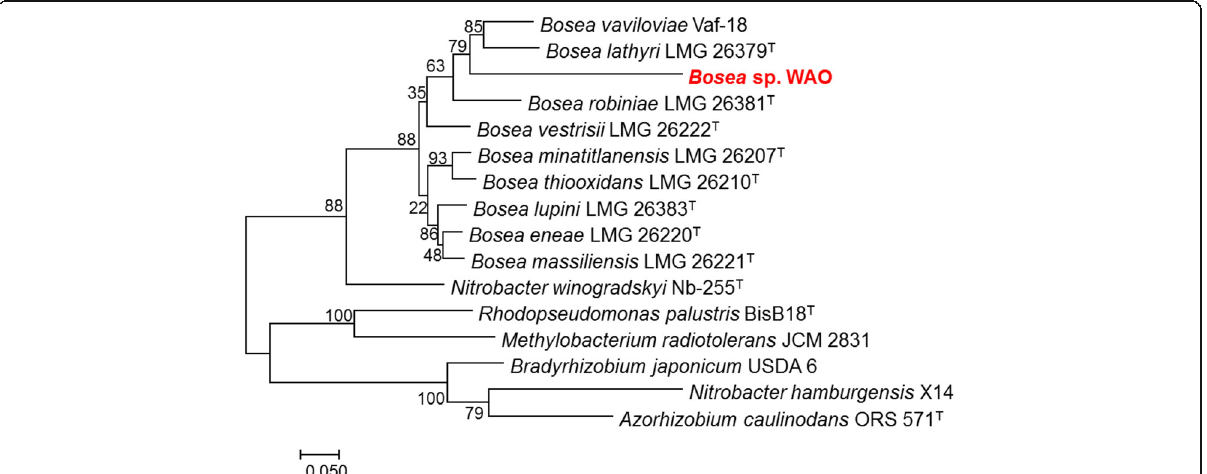
Fig. 2 Molecular Phylogenetic analysis by Maximum Likelihood method of aligned concatenated atpD , dnaK , gyrB , recA , and rpoB . The evolutionary history was inferred by using the Maximum Likelihood method based on the Tamura-Nei model [1]. The tree with the highest log likelihood ( − 13842.8588) is shown. The percentage of trees in which the associated taxa clustered together is shown next to the branches. Initial tree(s) for the heuristic search were obtained automatically by applying Neighbor-Join and BioNJ algorithms to a matrix of pairwise distances estimated using the Maximum Composite Likelihood (MCL) approach, and then selecting the topology with superior log likelihood value. The tree is drawn to scale, with branch lengths measured in the number of substitutions per site. The analysis involved 16 nucleotide sequences. All positions containing gaps and missing data were eliminated. There were a total of 1413 positions in the final dataset. Evolutionary analyses were conducted in MEGA7 [21]